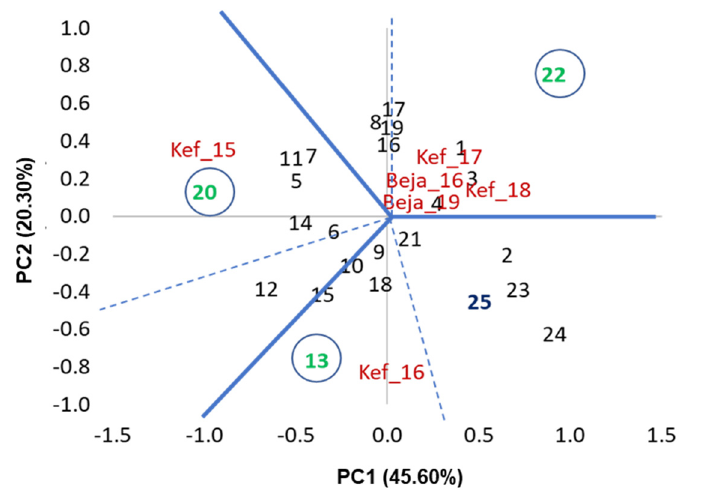
Figure 1. Genotype plus genotype × environment model (PC) based on grain yield of 25 durum wheat genotypes across the six environments.